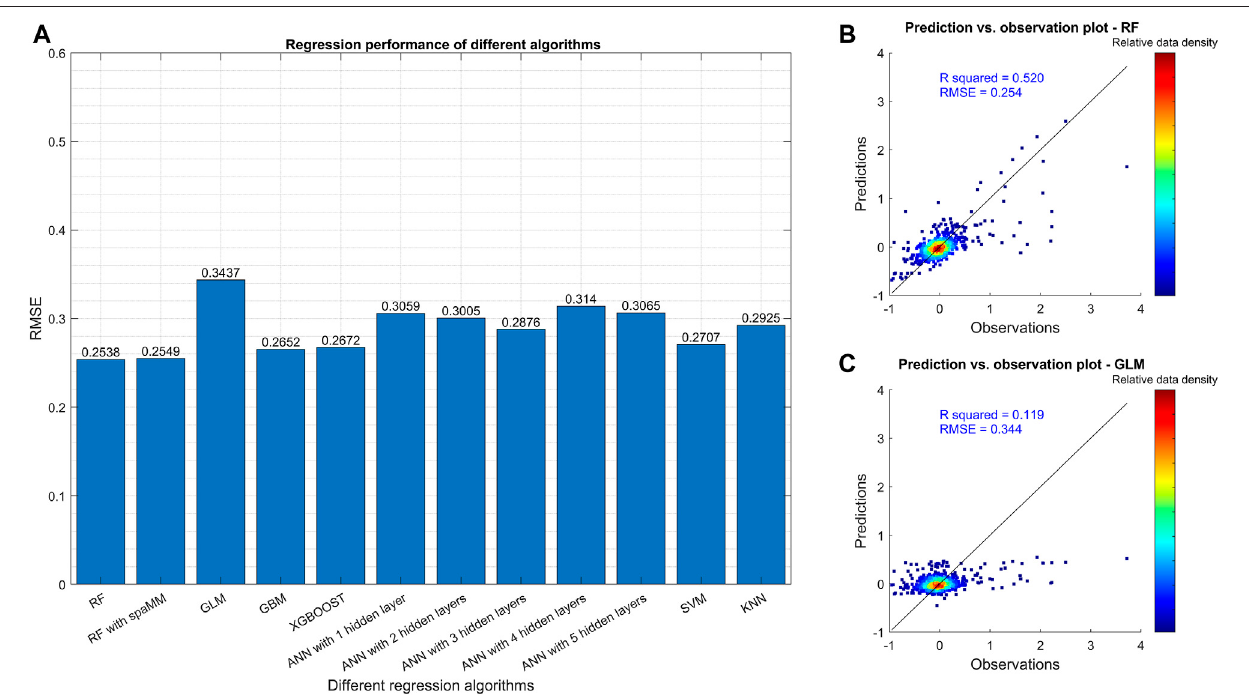
FIGURE3| Comparison ofdifferentregressionalgorithmsbased onRMSE.Plot (A) showstheRMSE inthe fi naltesting stepforthe various algorithmsafter model tuning. The number after ANN indicates the number of hidden layers in the neural networks. Plots (B,C) are the scatterplots of observations and predictions of relative crop yield change from the best (RF) and the worst (GLM) algorithms, respectively. All the models were trained with the training dataset in which the outliers (data points outside the 95% con fi dence interval) were fi ltered.